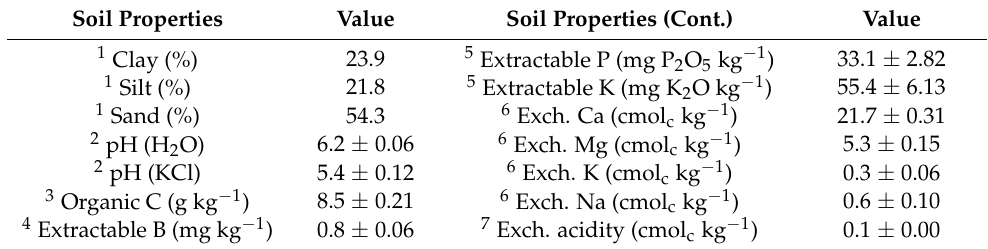
Table 1. Selected properties (average ± standard deviation; n = 3) of the soil (0–0.20 m depth) used in the pot experiments. Soil Properties Value Soil Properties (Cont.)